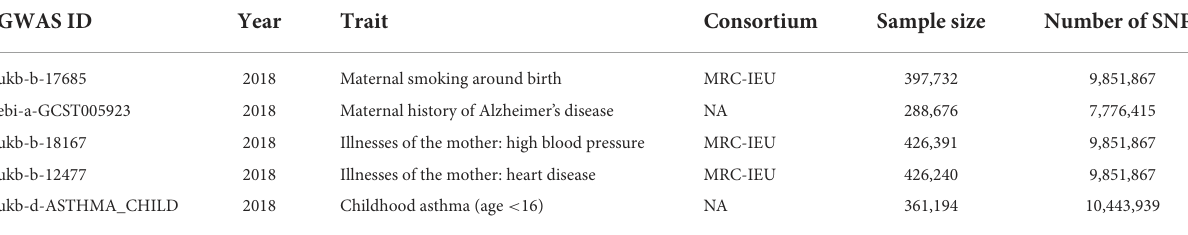
TABLE 1 Brief description of the genome-wide association study data used in this study. GWAS